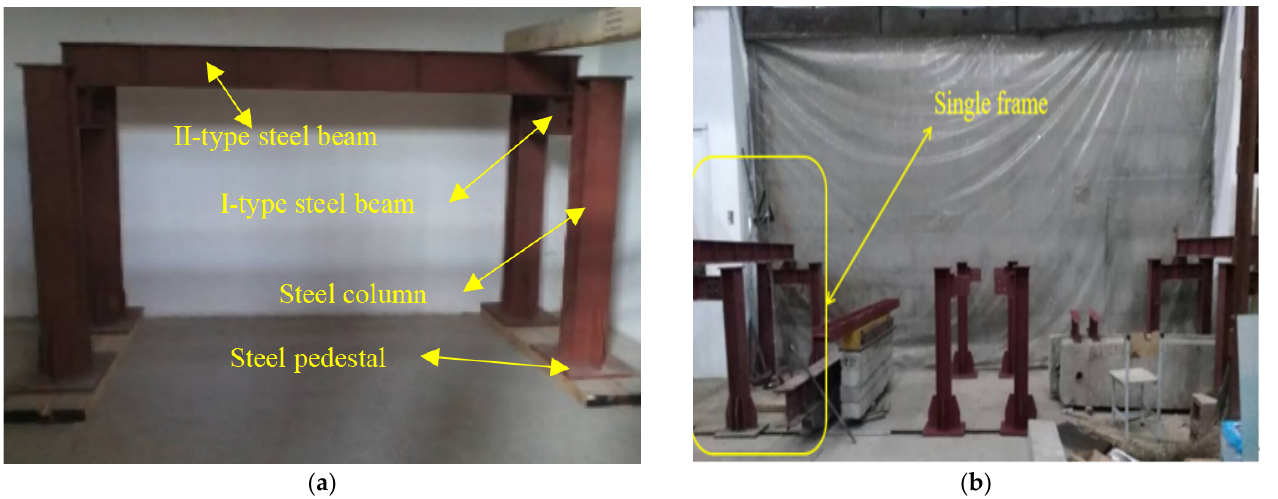
Figure 3. Long-term loading test device. ( a ) The composition of the single-loaded frame; ( b ) the whole loading support.